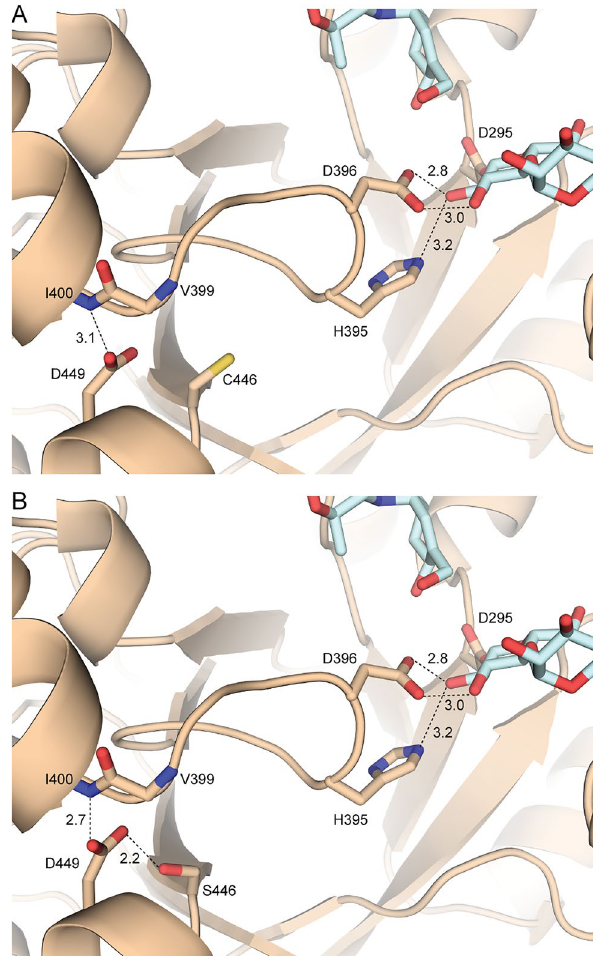
Figure 4. ( A ) Crystal structure of Sa AM (wheat) and carbohydrate residues (cyan) near C446. ( B ) Model of possible interactions when C446 is mutated to